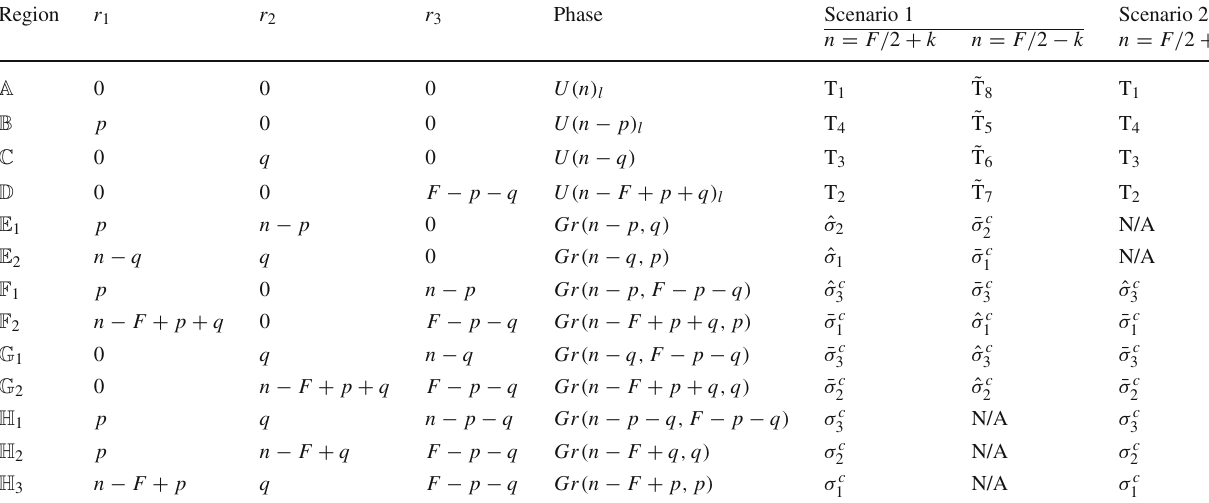
Table 2 Phases of the bosonic theory with q ≤ p ≤ F − p − q ≤ n < F